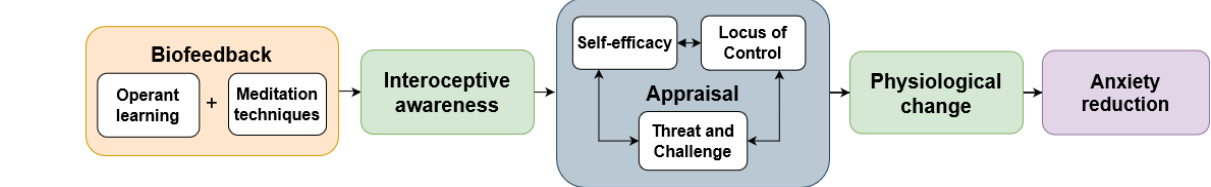
Figure 2. Integrative model of changes in real time including appraisal mechanisms.